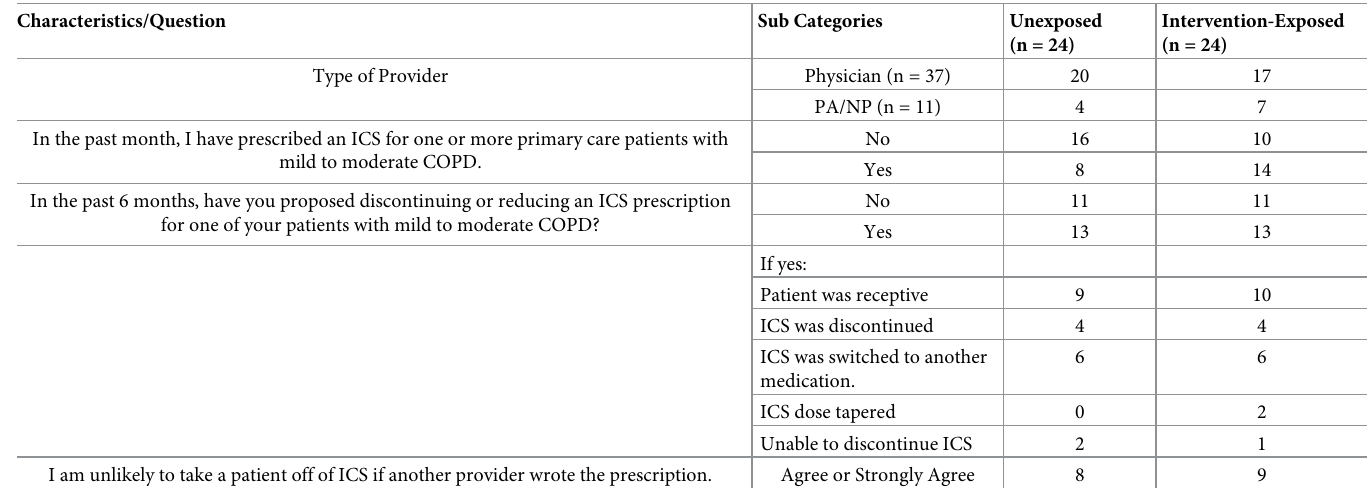
Table 3. Post-intervention survey